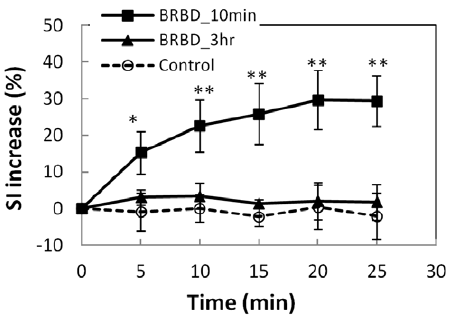
Figure 4. Recovery of the BRB 3 h after sonication at 0.81 MPa. The signal intensity (SI) increase measured in a ROI that included the retina and the vitreous humor is plotted as a function of time after two injections of MR contrast agent (Gd-DTPA). After the first injection (10 min after the last sonication), the SI increase was significantly larger (* p , 0.05; ** p , 0.01) than the controls for every point in the time- series. After the second injection (3 h after sonication), the SI changes were not significantly different than the controls ( p . 0.05) at any time point. Data shown are the average SI increase (mean 6 S.D.) for three sonicated eyes and four controls.